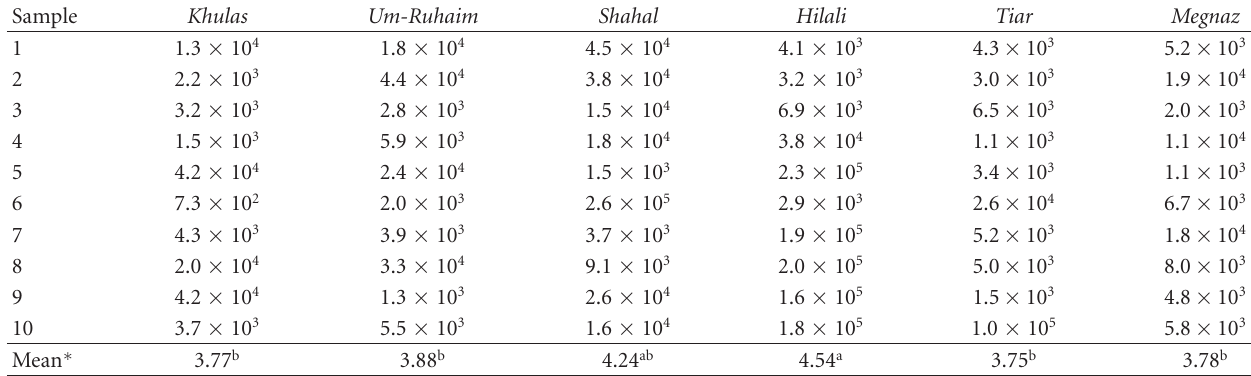
Table 1: Counts of aerobic mesophilic bacteria contaminating rutab samples (cfu/cm 2 ).